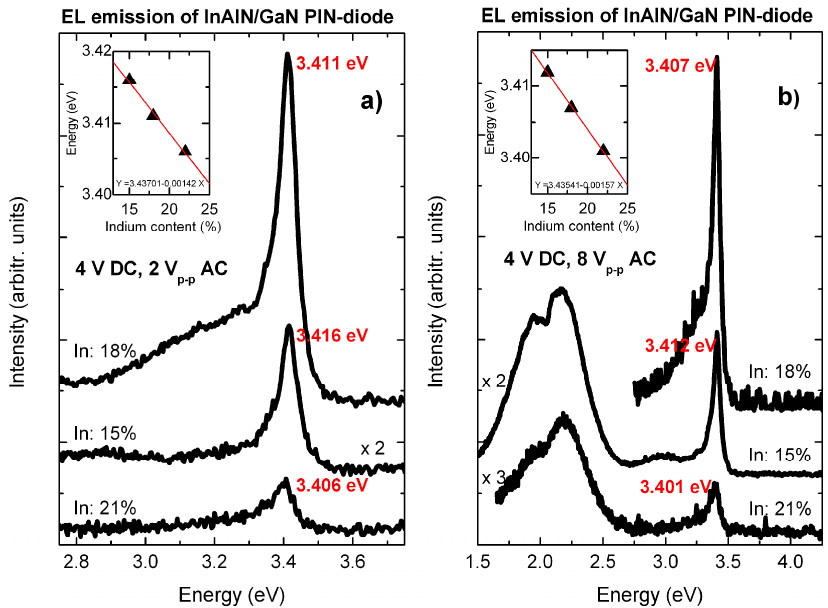
Figure 11. EL emission spectra of PIN-diodes based on In x Al 1-x N / GaN DHS in dependence of In-fraction x = 15, 18, and 21% and AC bias-voltage of ( a ) 2 V p-p and ( b ) 8 V p-p .